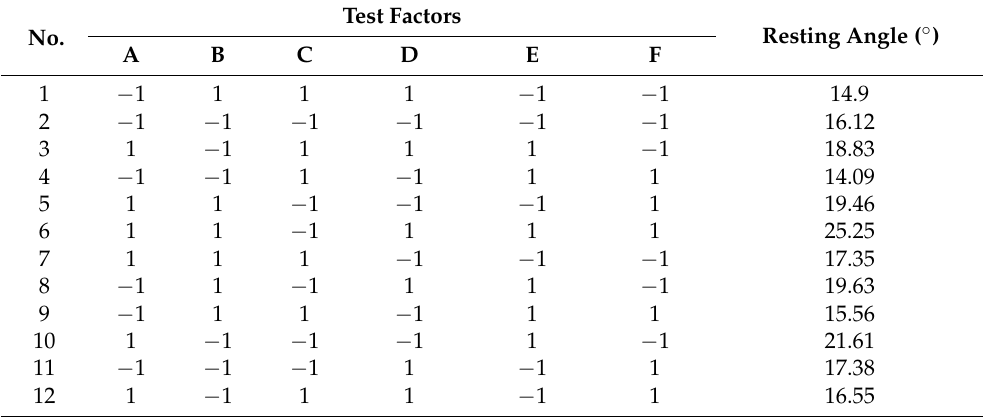
Table 3. Protocol and results of Plackett-Burman test. No.